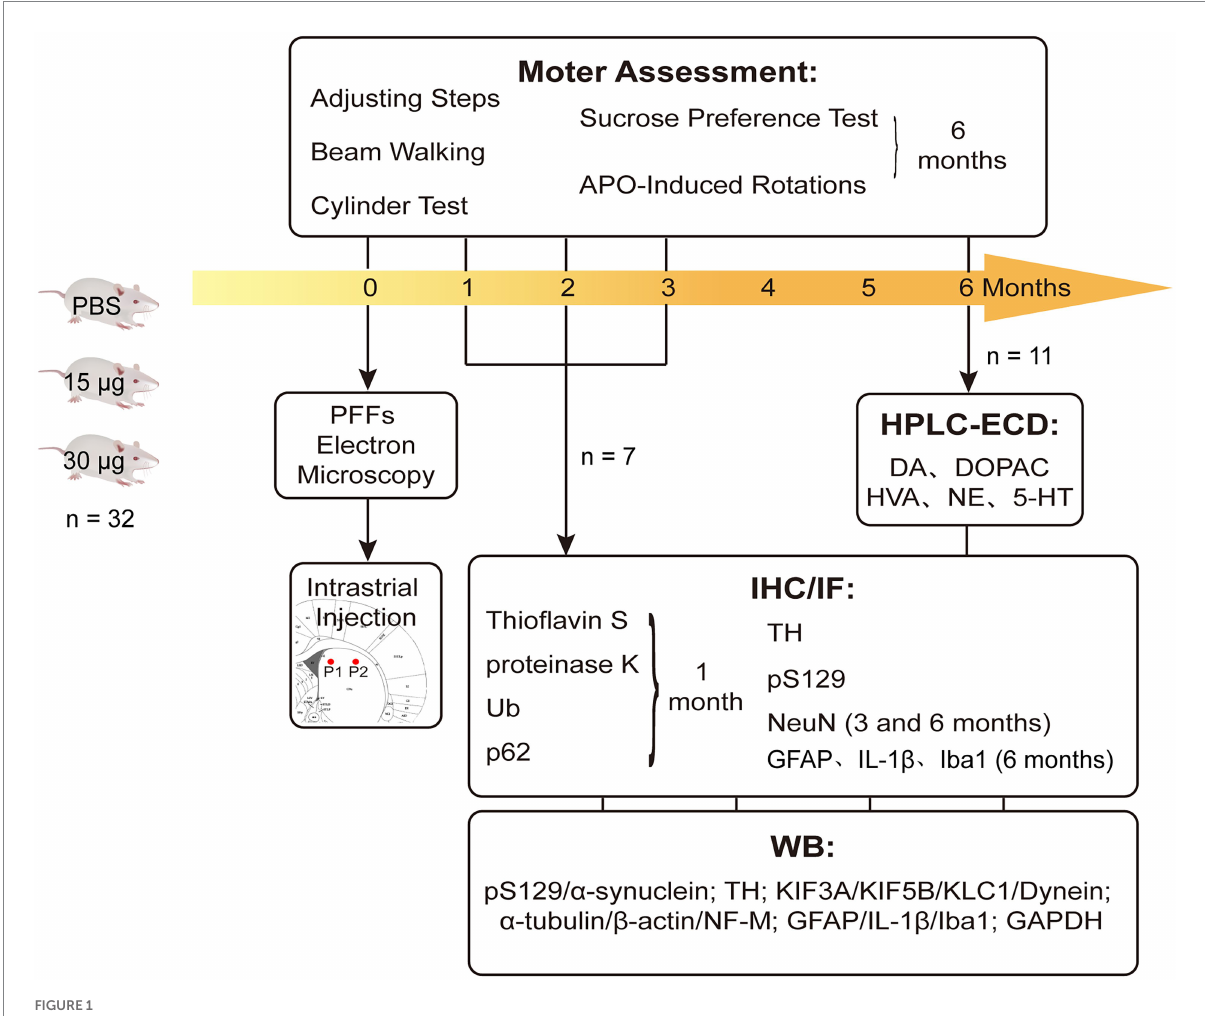
FIGURE 1 Experimental design and the endpoints. Rats were intra-striatal injected with either PBS vehicle or α -SynN103/tauN368 PFFs complex. Prior to injections, PFFs complex was tested with TEM to verify if effectively gathered. Locations of injections were pointed as P1 and P2 there. Brains were collected at 1, 2, 3 and 6 months post-injection for corresponding experiments. Behavioral tests were performed as well. IF measured thioflavin-S, α -Syn pS129, Ub and p62, as well as TH and NeuN. IHC measured α -Syn pS129, TH, NeuN and GFAP. WB was also performed to monitor nigrostriatal pathway changes, which contained α -Syn pS129, TH and axonal transport